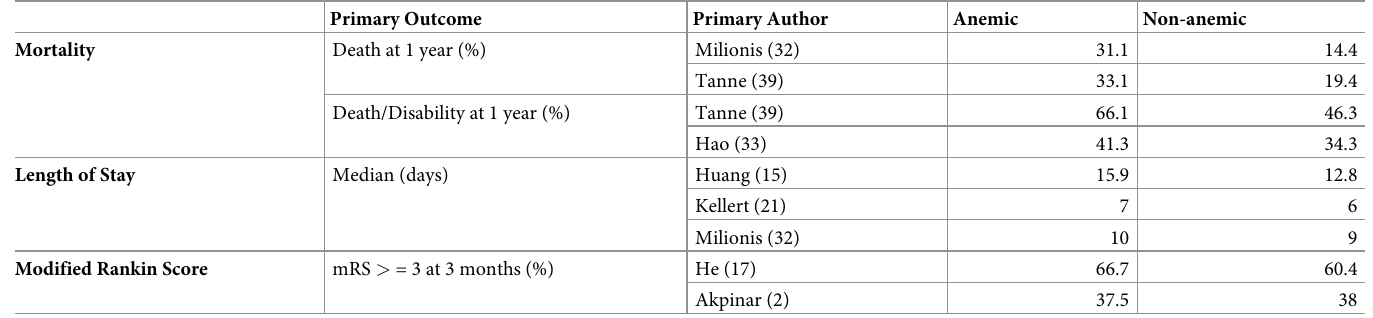
Table 2. Summary of included study